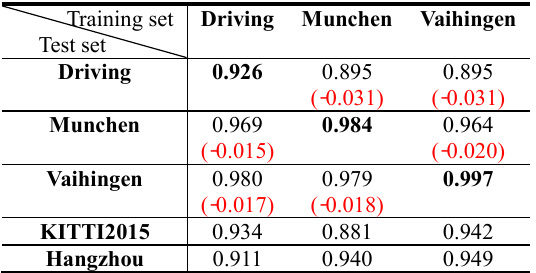
Table 2. Test results (parallax error < 3pixels) on the different training datasets based on GC-net. The numbers in bracket are the difference between the current number and the diagonal number of the current row, indicating the decreasing degree of accuracy when training with extern dataset. KITTI2015 and Hangzhou datasets lack of dense disparity map and are only used for test in